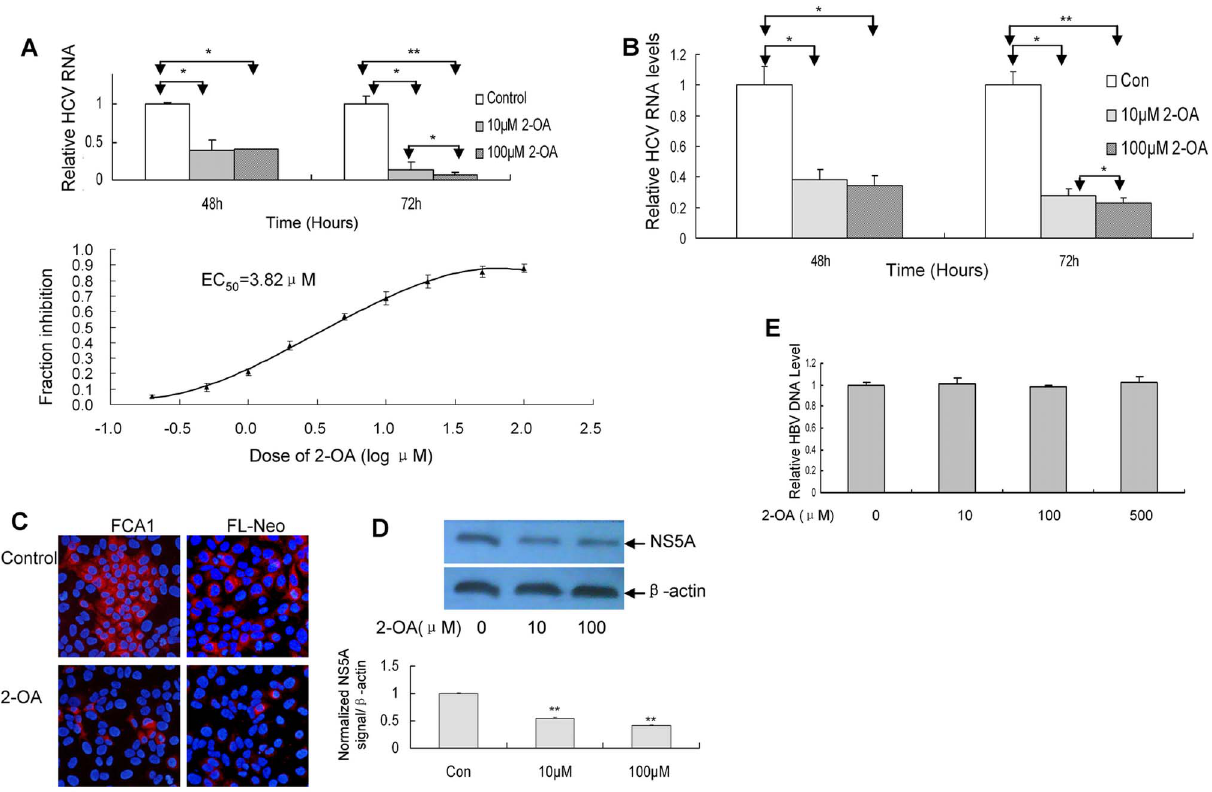
Figure 2. 2-OA inhibits HCV RNA replication in replicon cells. ( A/B ) FCA1 ( A ) and FL-Neo ( B ) were incubated with 10 m M or 100 m M 2-OA for 48, 72 hours. HCV RNA was detected with real-time PCR and normalized with internal control GAPDH. EC50 of 2-OA is obtained from Figure 2A (Lower). ( C ) FCA1 and FL-Neo were incubated with 100 m M 2-OA for 48 hours and immunostained with mouse monoclonal anti-NS5A antibody (red). DAPI was used for nuclear counterstaining (blue). Identical settings were maintained for image capture. Representative images are shown. ( D ) FCA1 cells were treated with 2-OA for 48 hours. NS5A protein was detected with western blot (upper) and quantified by densitometry in comparison with b -actin (lower). ( E ) 2-OA did not affect hepatitis B viral DNA replication. HepG2.2.15 cells were inoculated with different doses of 2-OA for 72 hours. Intracellular HBV DNA was detected with real-time PCR and normalized with GAPDH.